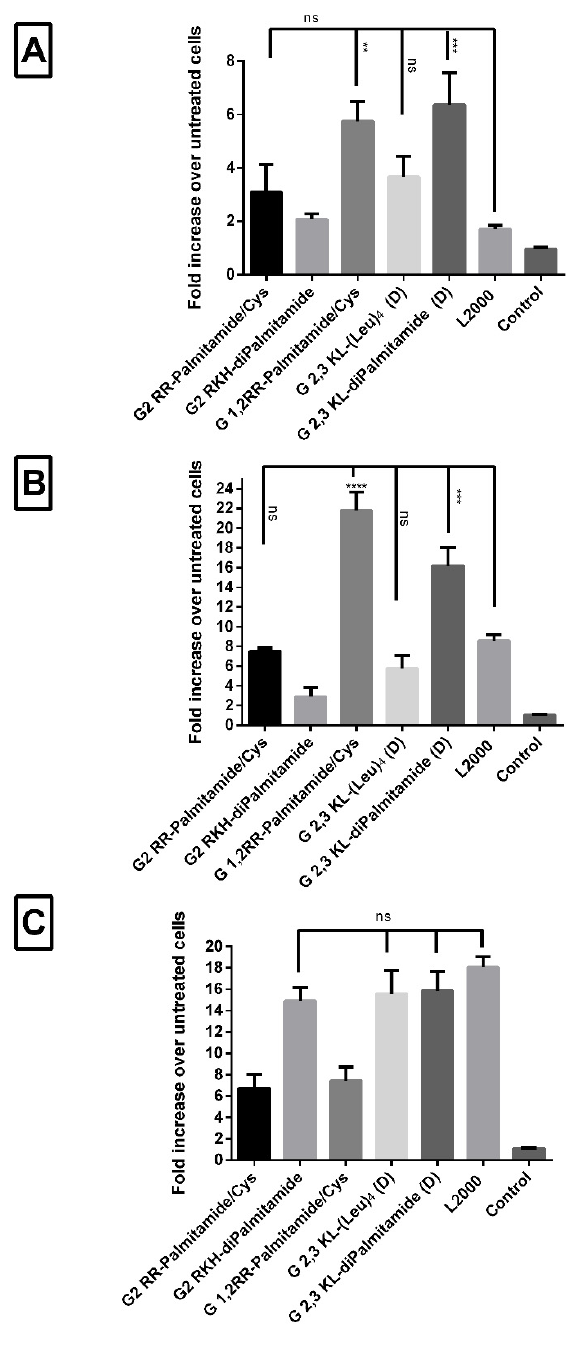
Figure 7. Transfection efficiency of peptide dendrimer/ON complexes in different cells. Com- parisons of the fold increase in luciferase activity after transfection with selected 2nd and 3rd generation peptide dendrimers in serum-containing media in three different cells. ( A ) HuH7/705, ( B ) N2a/705, and ( C ) U-2 OS/705. All complexes were formulated in OptiMEM ® except for G2 RKH-diPalmitamide and G 2,3 KL-diPalmitamide (D) in HBG. ON complexed with L2000 was used as positive control and ON alone as negative control. ON concentration: 100 nM. Each bar represents the mean with the SEM of at least three experiments done in triplicate ( n ≥ 3). p -values calculated by one-way ANOVA test, and statistical difference in the transfection efficiency between L2000 and peptide dendrimer/ON complexes was compared using post hoc Fisher’s LSD test (ns: non-significant, ** p ≤ 0.01, *** p ≤ 0.001 and **** p ≤ 0.0001).